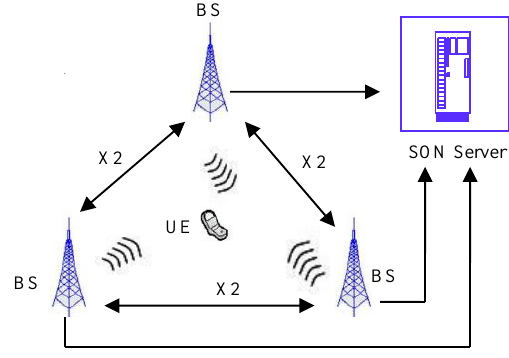
Figure. 1. Network Analytics by UE assisted